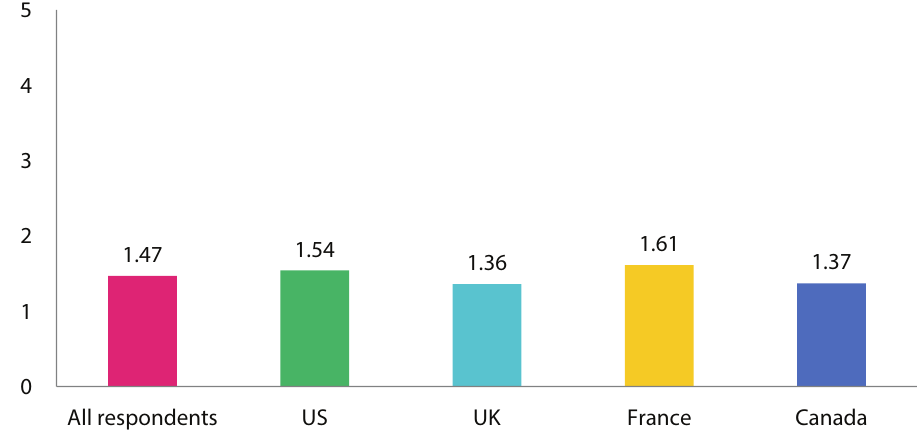
Figure 1. Awareness of false news stories about Covid‐19.